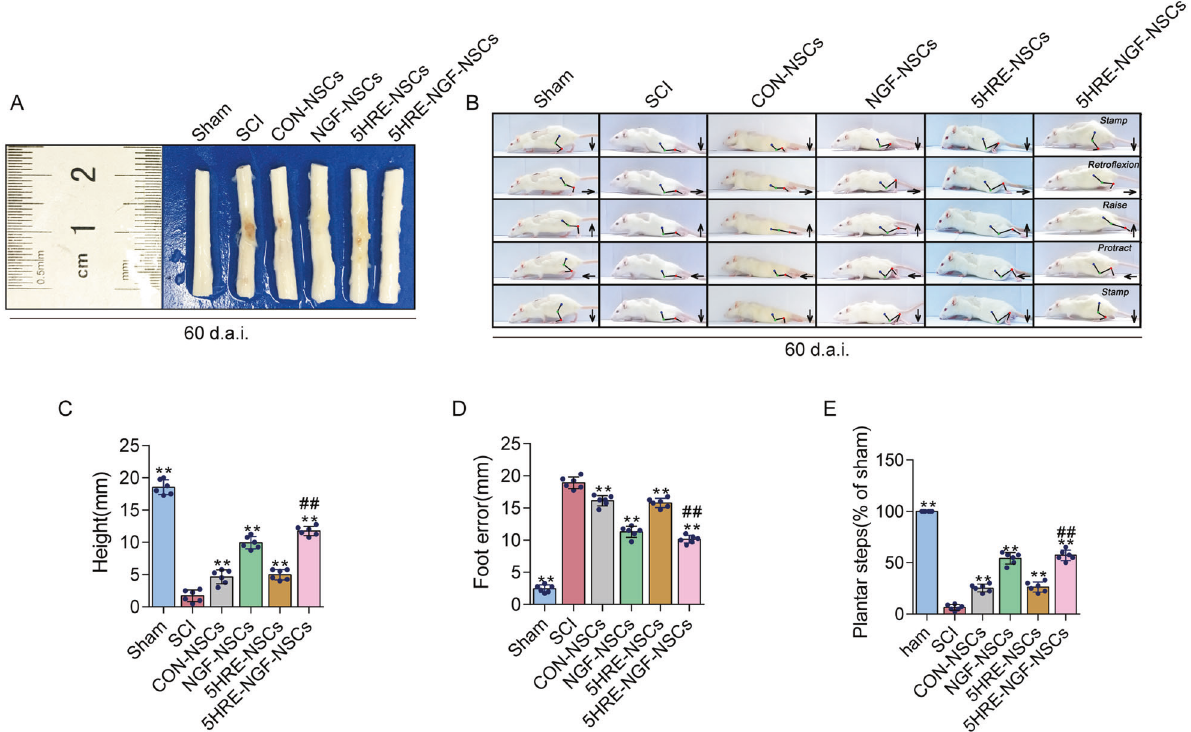
Fig. 3 NGF promoted and protected the spinal cord tissues, improving the recovery of locomotor function. A Images of spinal cords in Sham, SCI, CON-NSCs, 5HRE-NSCs, 5HRE-NGF-NSCs group. B Video images sequence of rats 2 months after operation. Impaired hindlimb function while crawling is apparently manifested by powerless weight support (calculated as torso height minus ground), leg-extensor spasms (calculated as spasm interval relative to each step cycle duration), slow steps (quantity of hind-limb plantar steps each step cycle of forefoot) and weak foot placement (caudal to behind hip). Hip (iliac crest), knee and ankle joints are indicated by dots and lines. The arrow shows foot movement. Scale bar = 20 mm. C – E ** signi fi es P < 0.01 versus the SCI group, ## signi fi es P < 0.01 versus the NGF-NSCs group. Data are the mean values ± SD, n = 6.